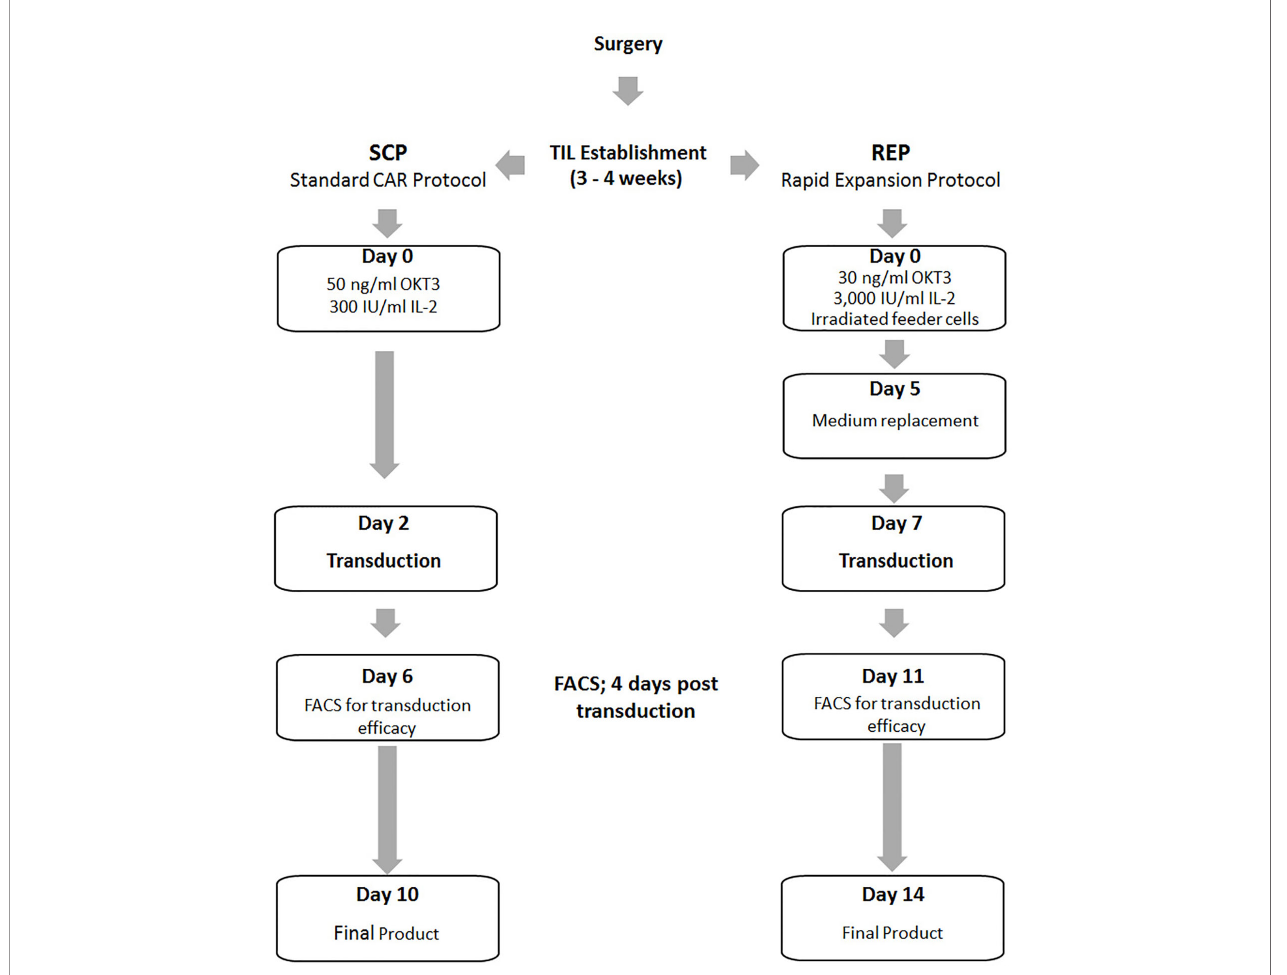
FIGURE 1 | Schematic illustration of the Standard CAR Protocol (SCP) compared to the Rapid Expansion Protocol